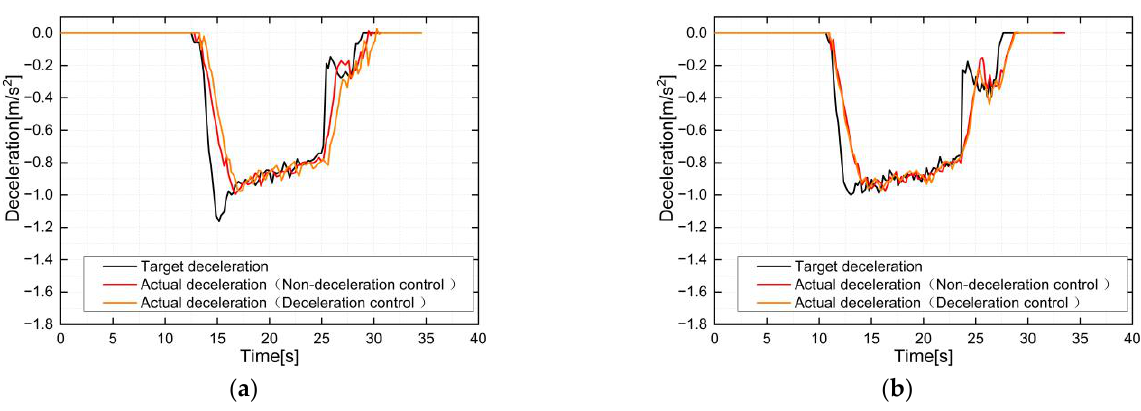
Figure 16. ATO mode parking test results: ( a ) Test 1; ( b ) Test 2.